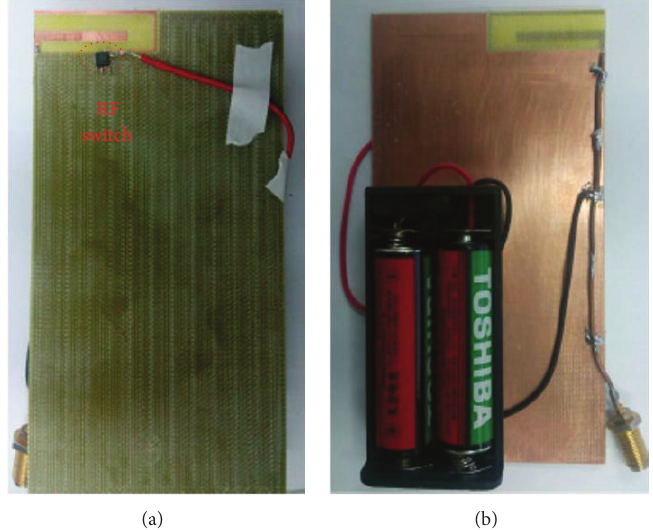
Figure 3: Photos of the manufactured reconfigurable antenna for eight-band mobile handset applications.